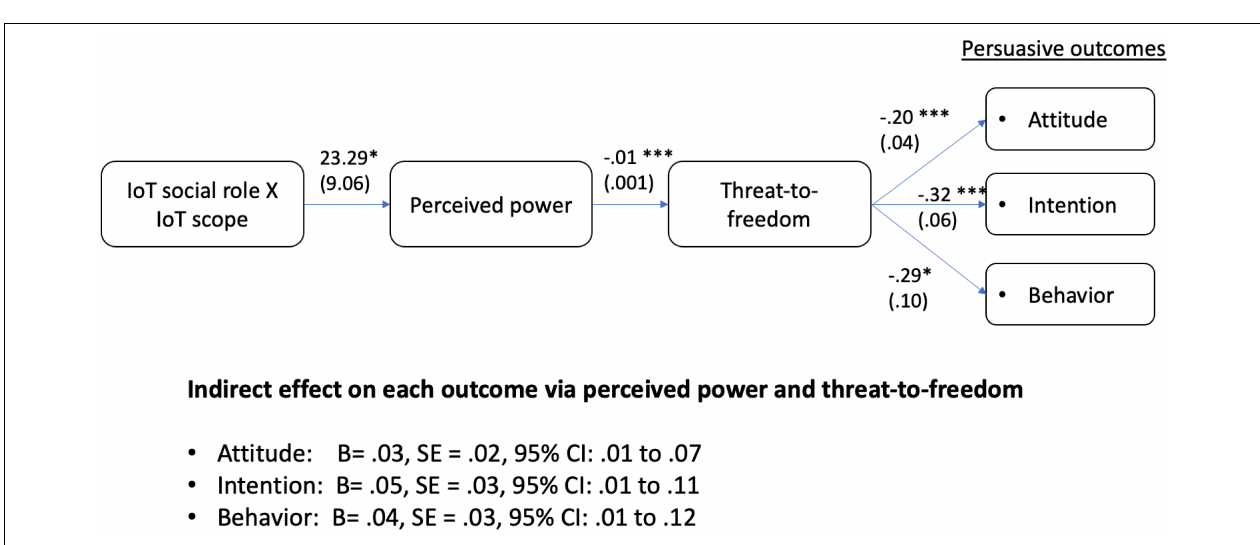
a longitudinal approach, future research may explore how